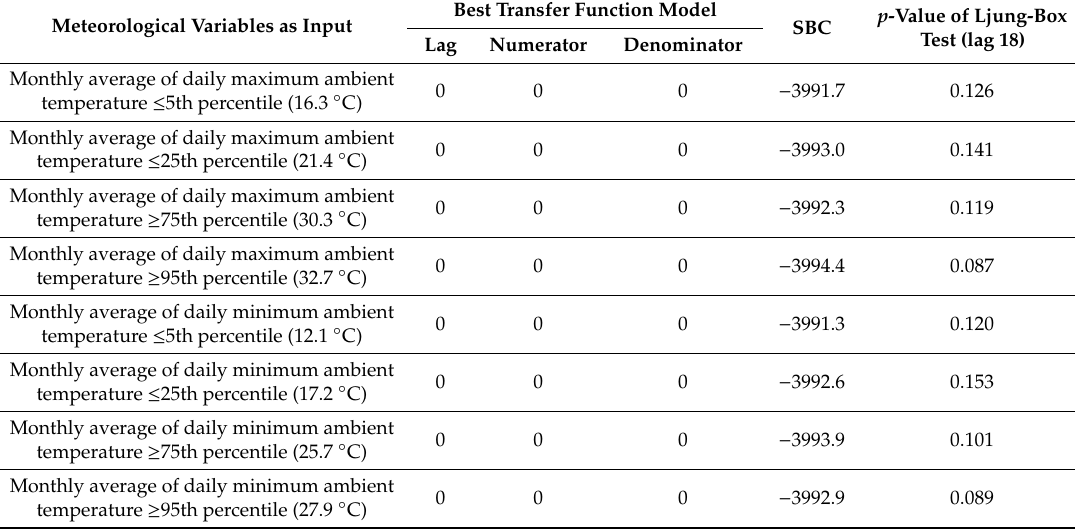
Table A4. Transfer function models for the rate of older-adult suicide deaths from nonviolent methods (Sensitivity